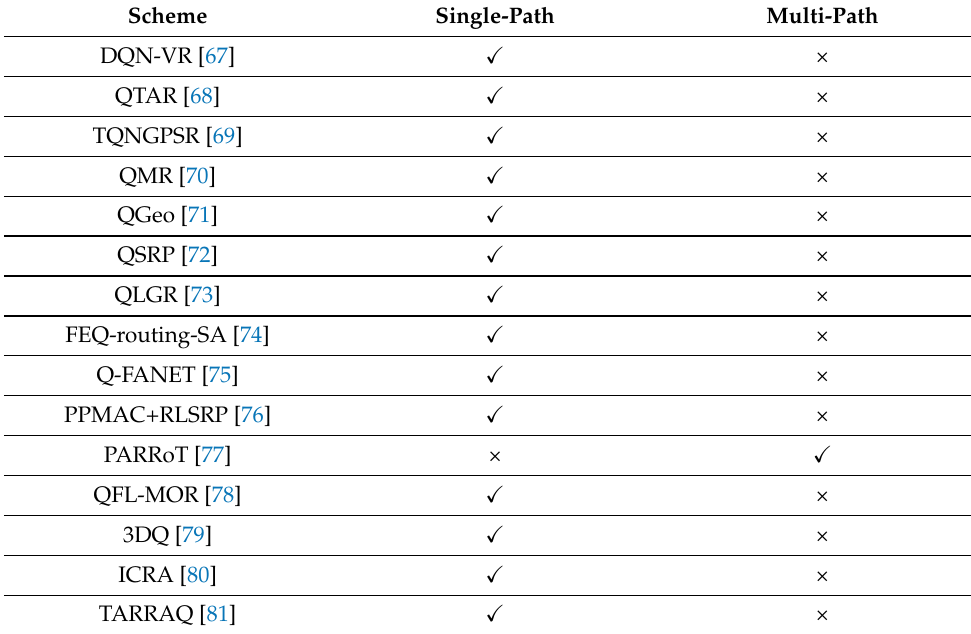
Table 28. Comparison of RL-based routing methods by data